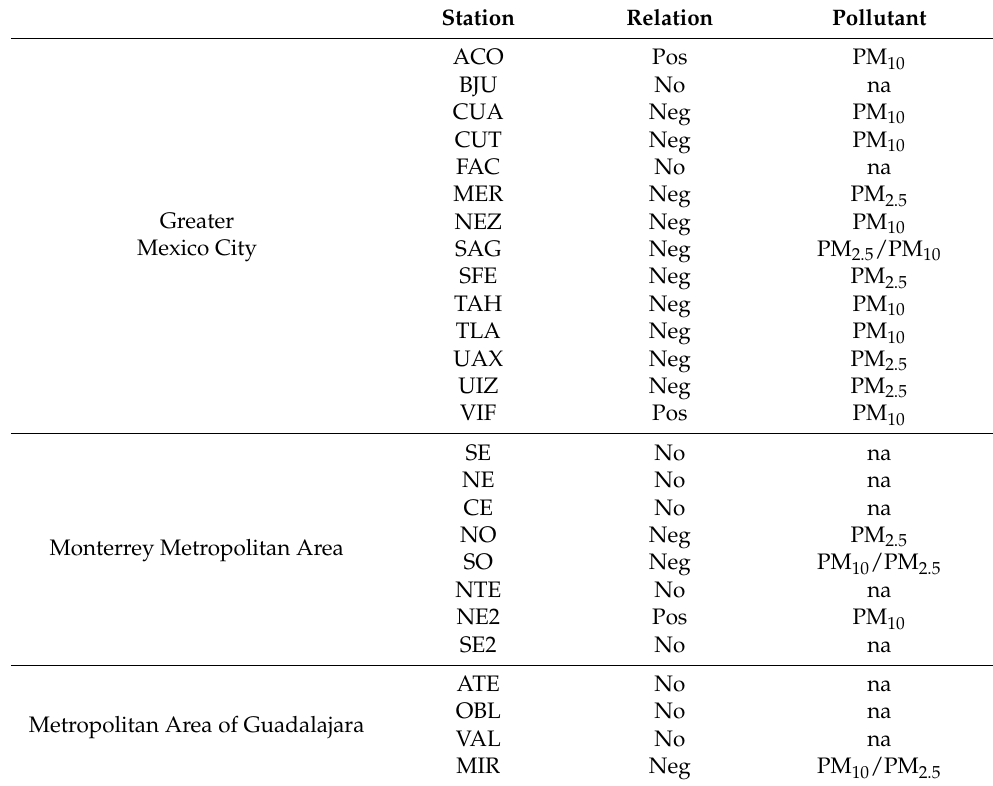
Table 4. Statistically significant relations between wind speed and PM concentrations. The relation can be positive (pos), negative (neg), or non-existent (no). Not available (na). Station Relation Pollutant ACO